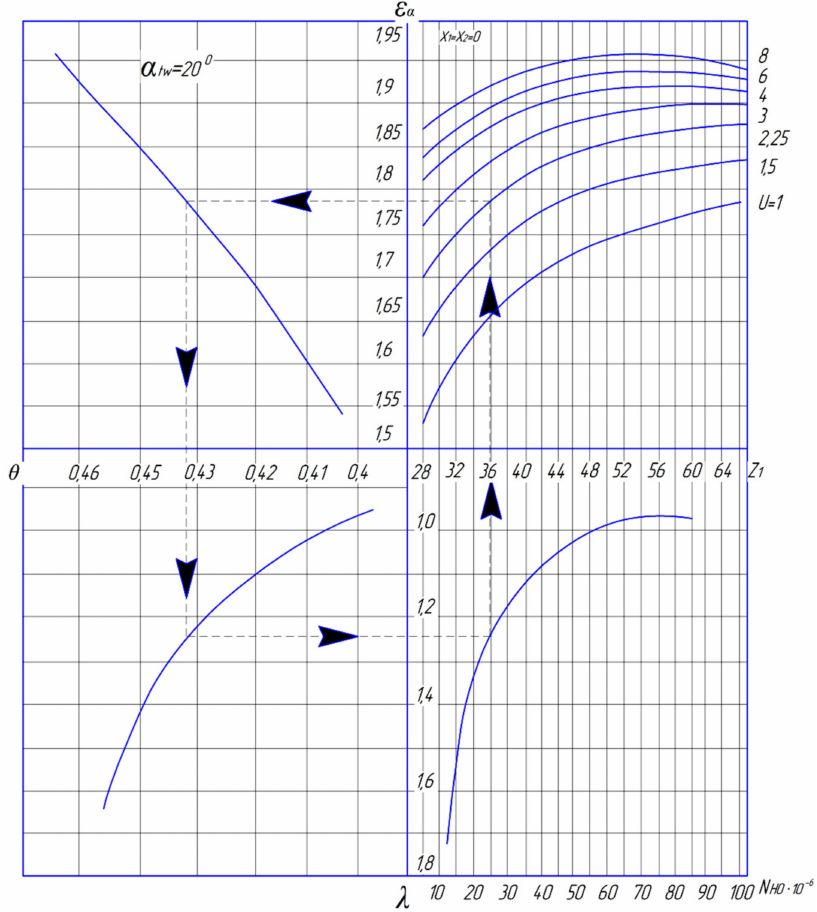
Figure 6. Nomogram for determining the dependence of the basic cycles of contact stresses from the change in the load distribution factor and the factor of the contact spot deviation from the design axis λ . θ is the coefficient of uneven load distribution along the length of the tooth, and λ is the coefficient of deviation of the contact spot from the design axis of